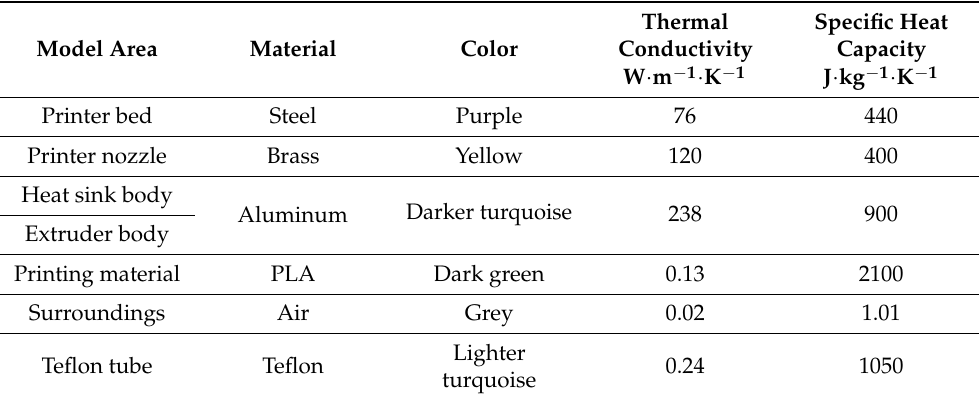
Table 2. Material parameters of the static